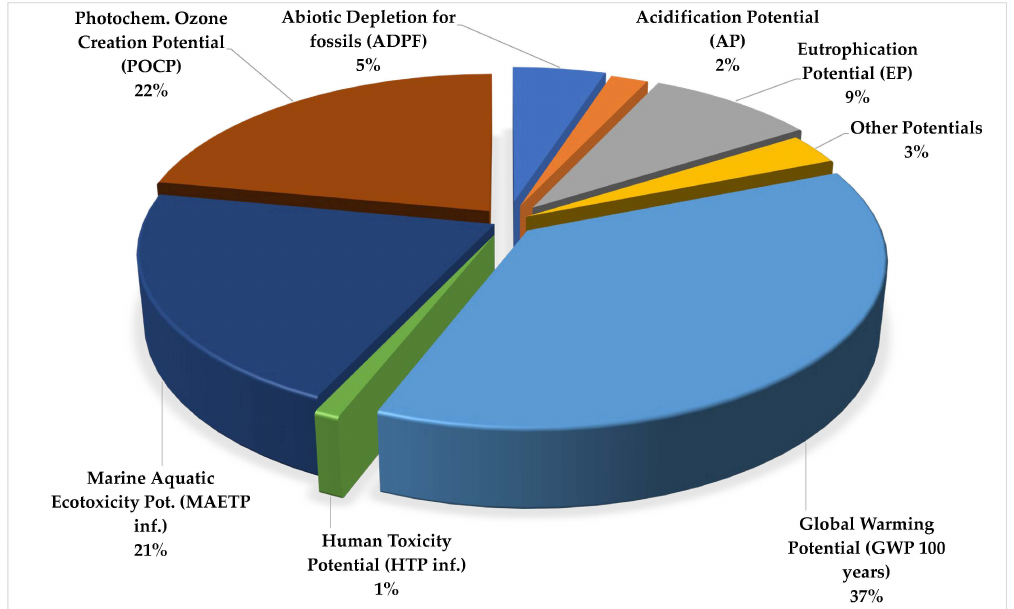
Figure 7. Environmental impact categories for Scenario 1 of the end-of-life stage with transport (functional unit: food waste of 0.05 kg. Normalisation reference: CML 2016, EU 25 + 3, year 2000, excl. biogenic carbon. Weighting method: thinkstep LCIA Survey 2012, Europe, CML 2016, excl. biogenic carbon).